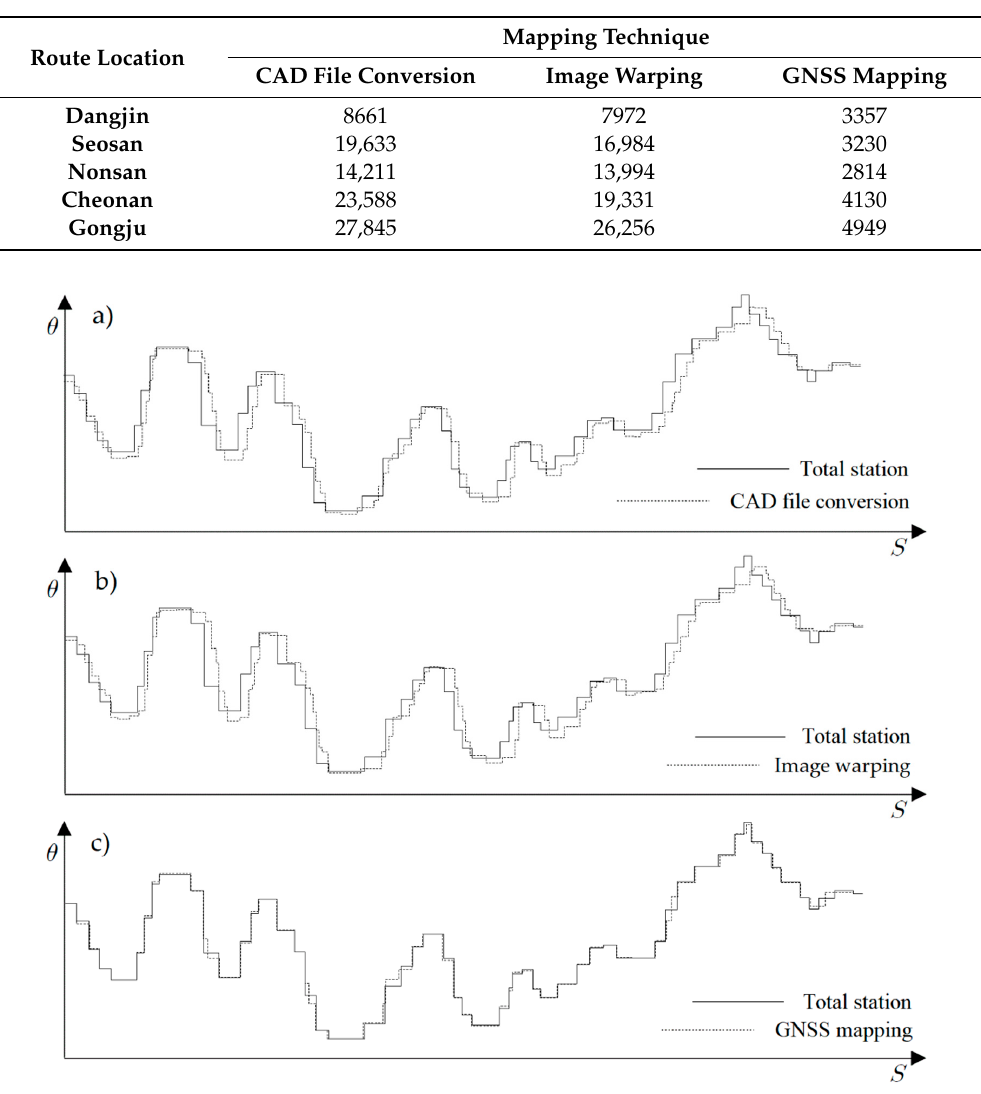
Table 5. Area size difference in turning function analysis between the three mapping techniques and reference map.